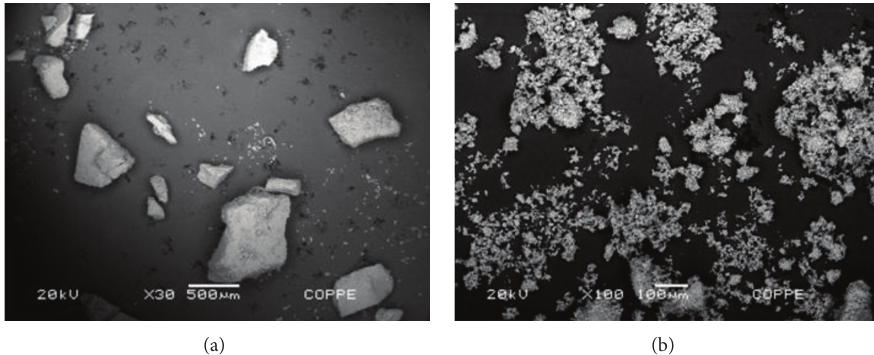
Figure 3: SEM images of LDH ((a) magnification: 30x) and Pd/LDH composite ((b) magnification: 100x).